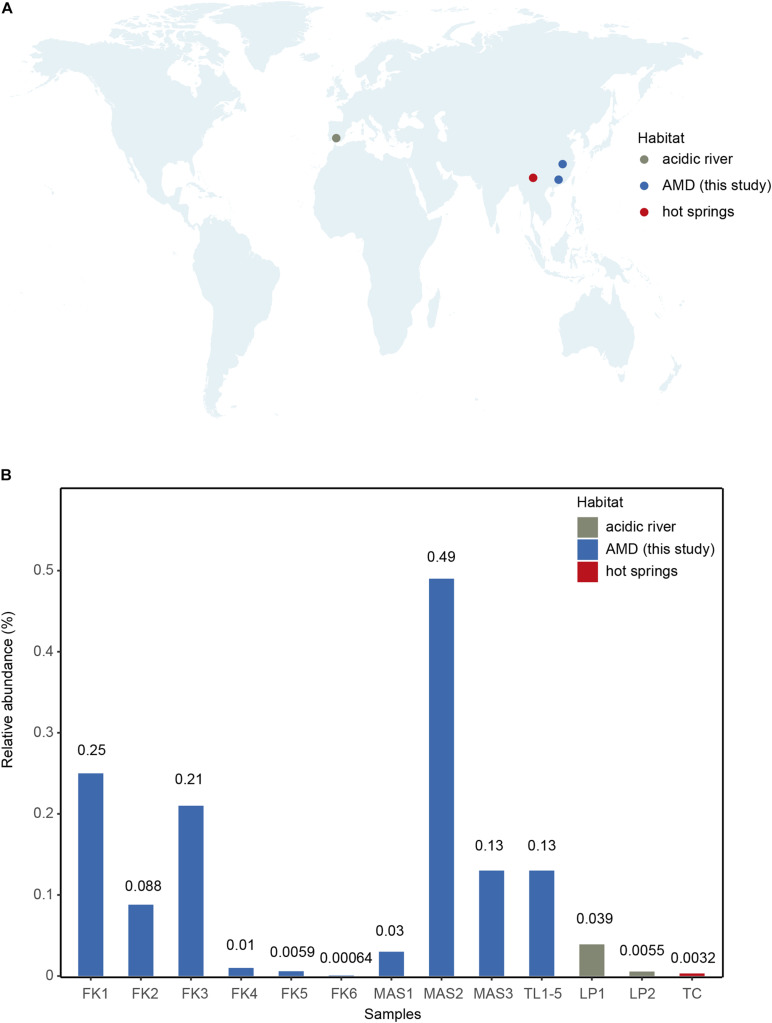
(A) Global distribution of the 16S rRNA genes of newly recovered Parvarchaeota MAGs based on IMNGS database with 97% sequence-identity threshold. The retrieved 16S rRNA sequences were plotted with different colors on the global map. (B) The relative abundance of newly recovered MAGs calculated by the number of 16S rRNA gene sequences over the whole size of corresponding samples.